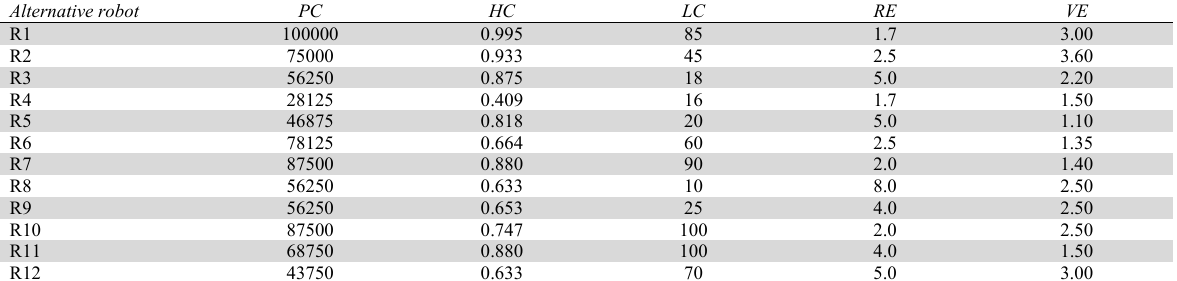
Data table for example 2 (Braglia & Petroni, 1999; Karsak & Ahiska, 2005, 2008; Wang & Chin, 2009; Singh & Rao, 2011; Rao, 2013)